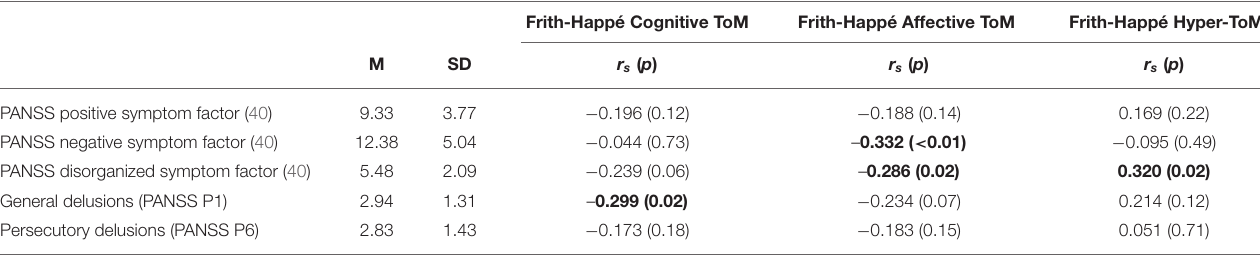
TABLE 3 | Spearman correlation coefficients between Cognitive ToM, Affective ToM, Hyper-ToM, and clinical symptoms in patients with